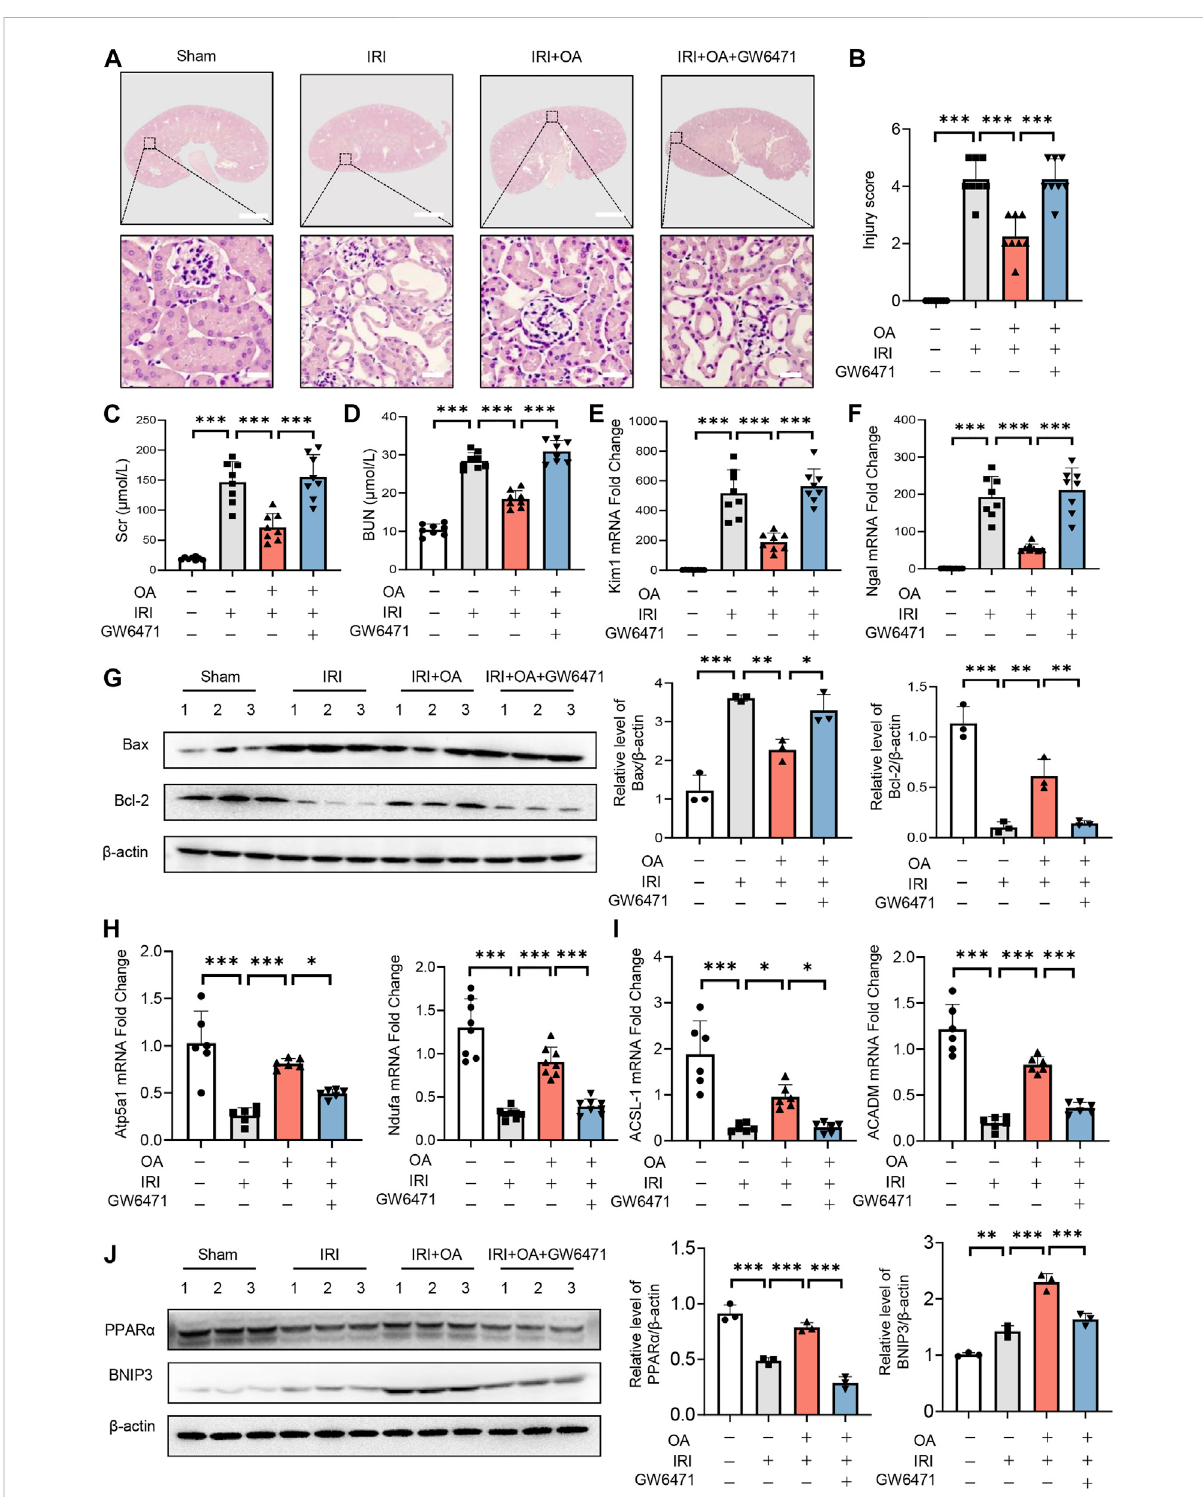
FIGURE 7 PPAR α inhibition reversed the protective effect of OA in AKI mice. (A) OA-treated Sham and AKI mice were injected with control or PPAR α antagonist. RepresentativeHEstainingimagesofkidneysectionsfromshamandAKImicetreatedwithcontrolorOAincombinationwithorwithoutPPAR α antagonist. Scale bars, 1.25 mm (top) and 50 μ m (bottom). (B) Quantitative assessment of tubular damage ( n = 8). Effects of OA on serum Scr (C) and BUN (D) ( n = 8). mRNAlevelsofKim-1 (E) andNgal (F) byqPCR( n =8). (G) TheexpressionsofBcl-2andBaxinkidneytissueswereanalyzedbyWesternblotanalysis( n = 3). (H , I) The expression levels of OXPHO-related gene (H) and FAO-related gene (I) ( n = 8) were detected by qPCR. (J) The expression levels of PPAR α and BNIP3 in kidney tissues were measured by Western blot ( n = 3). Data are expressed as means ± SEM. p P < 0.05, pp P < 0.01, ppp P <